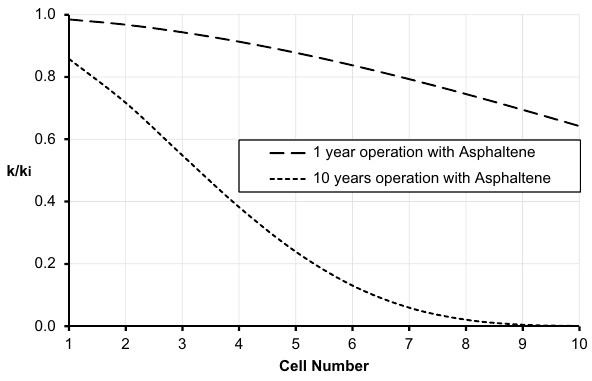
Fig. 8 Effect of production time on permeability alteration by asphal- tene deposition using k f / k m of 10